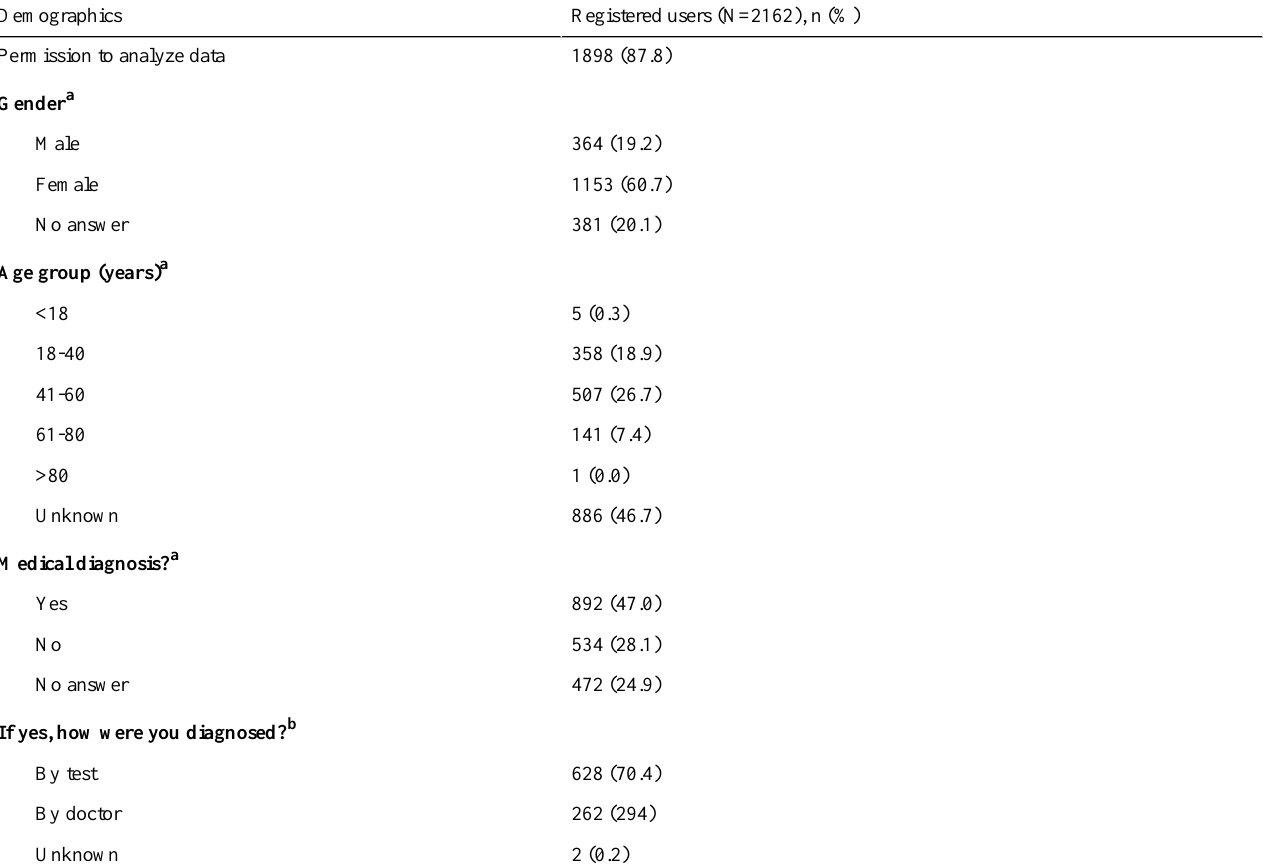
Table 2. Profile of registered users (self-registration).